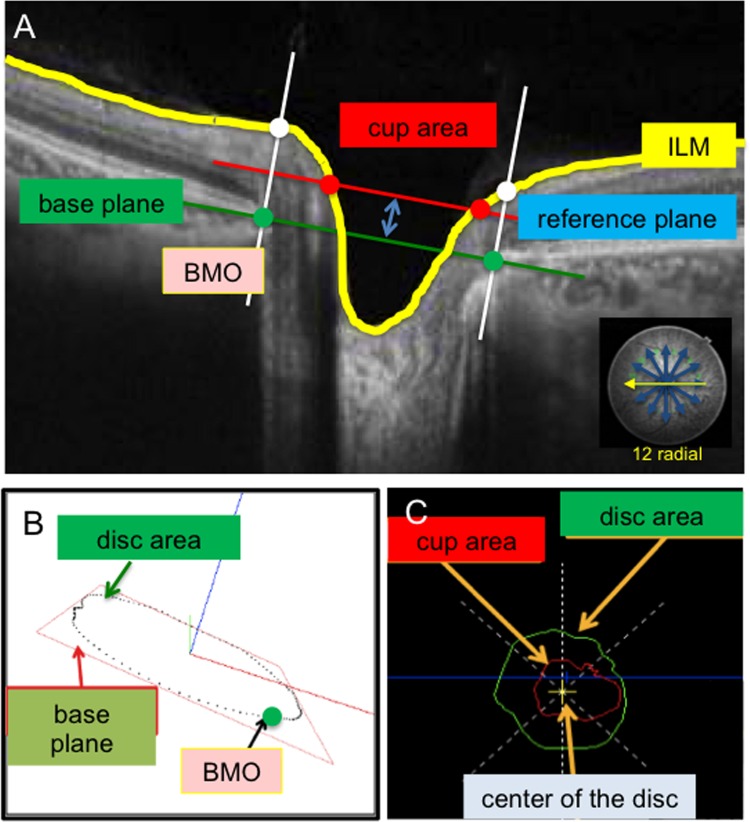
Definition of disc parameters.(A) The base plane was an approximation, drawn through the BMO points, which indicated disc area. The reference plane was set above the base plane at a height varying from 60 to180 μm (in 30 μm steps). Intersections of the ILM and the reference plane indicated the cup area. (B) Method for determining a vertical line against the base plane. (C) Definitions of cup area and disc area. ILM: inner limiting membrane. BMO: Bruch’s membrane opening.